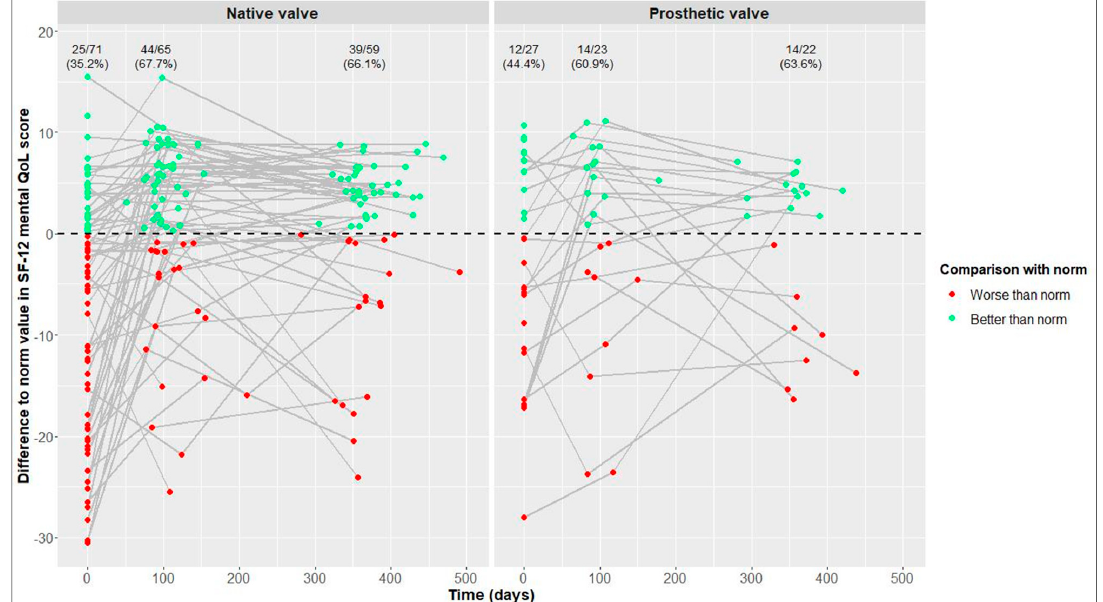
Figure 6. Differences between our values and reference values of 12-Item Short Form Health Survey (SF-12) mental quality of life (QoL) [21] in native valve vs. prosthetic valve patients; measurements of individual patients are represented by separate dots and connected to show time trend; absolute and relative frequencies of patients reaching reference values are displayed (raw